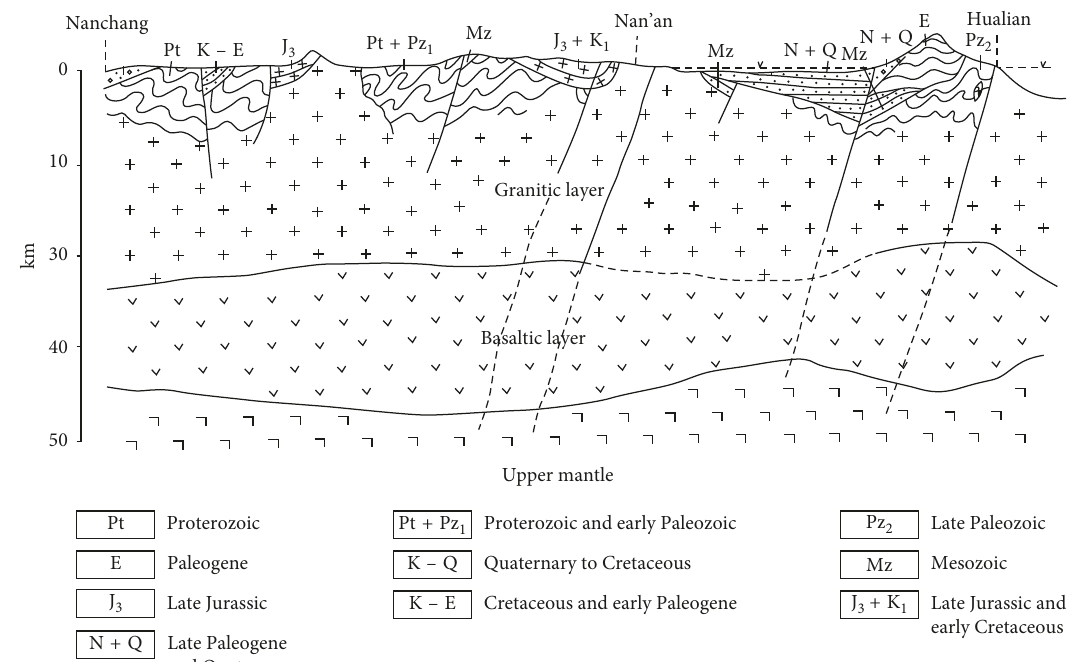
Figure 2: The geologic structure of the area around Nan’an city.